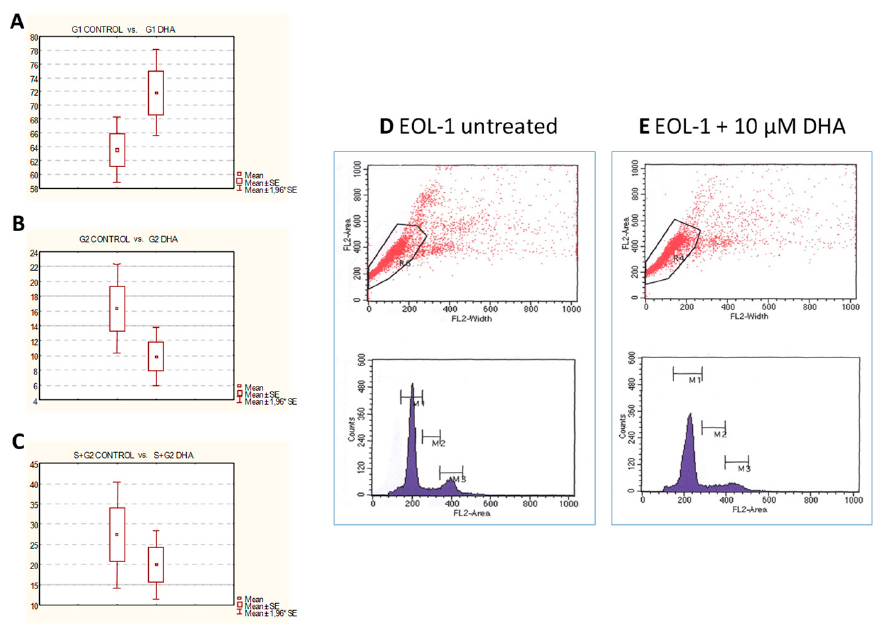
Figure 4. Cell cycle analysis of EoL-1 cells by flow cytometry with propidium iodide staining. Cell cycle analysis showed a shift of cells into the G0/G1 phase from the S/G2 phase following treatment with 10 µ M DHA. ( A ) G0/G1 phase: 71.81% ± 6.38% for DHA vs. 63.57% ± 4.79% for control ( p < 0.01). ( B ) G2 phase: 9.85% ± 4.01% for DHA vs. 16.32% ± 6.10% for control ( p < 0.01). ( C ) S + G2 phases: 19.94% ± 8.56% for DHA vs. 27.30% ± 13.37% for control ( p < 0.05). DNA histograms of cell cycle distribution: ( D ) Untreated EoL-1 cells. ( E ) DHA (10 µ M for 72 h) treated EOL-1 cells. Representative graph.